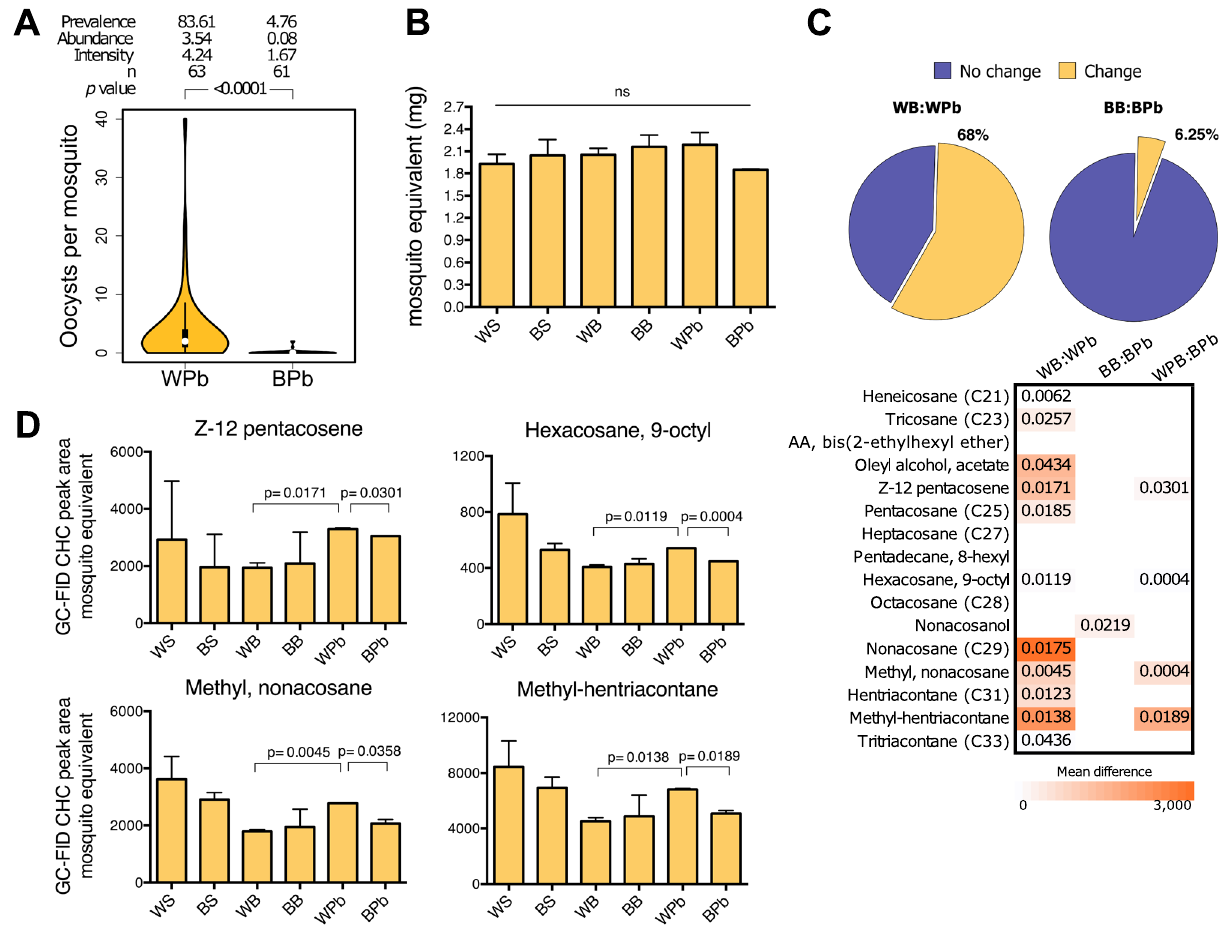
Figure 2. P. berghei infection alters the CHC composition. ( A ) Infection parameters of the White-susceptible and Brown-resistant phenotypes fed with infected blood (WPb; BPb, respectively). White and Brown females 5 (dpe) were challenged with 900 ookinetes per microliter of a P. berghei strain that constitutively expresses the GFP protein. Three days post-challenge, the midguts were dissected, and the abundance, intensity and prevalence of the infection were determined by fluorescence microscopy. Results of two independent experiments with approximately n = 30 mosquitoes for each group. Data was analyzed with the Mann–Whitney U test. ( B ) Mosquito-equivalent mass (mass/50 mosquitoes) of the White and Brown phenotypes with different diets based on 8% sucrose solution (WS; BS), blood (WB; BB), and infected blood (WPb; BPb). Three days post-feeding, the mass of 50 mosquitoes per group was measured to extract the cuticular hydrocarbons afterwards. Representation of the mean ± standard error of the mean (SEM) of three independent experiments. ( C ) Percentage of CHCs that changed significantly between the blood-fed and infected blood-fed mosquitoes (pie charts of White blood vs. White Pb-challenged, left; and of Brown blood vs Brown Pb-challenged, right). Heat map showing which CHCs changed significantly between the blood-fed and Pb-challenged mosquitoes per phenotype and between phenotypes for the challenged condition. The colour gradient represents the mean difference of the CHC GC-FID area of mosquito extracts between the different conditions (WPb:WB, BPb:BB, and WPb:BPb). Only compounds with significant differences were represented with colour, white boxes represent no significant change. The numbers in the boxes are the p -values calculated by a two-tailed t test of two independent experiments performed in triplicates. ( D ) CHCs with significant changes between the susceptible and resistant phenotypes fed with different diets and Plasmodium -challenged. GC-FID lipid area of mosquito extracts of the two phenotypes with diets based on 8% sucrose (WS; BS), blood (WB; BB), and infected blood (WPb; BPb). Mean ± SEM of two independent experiments performed in triplicates each with 50 mosquitoes per group. p -values of pairwise two-tailed t